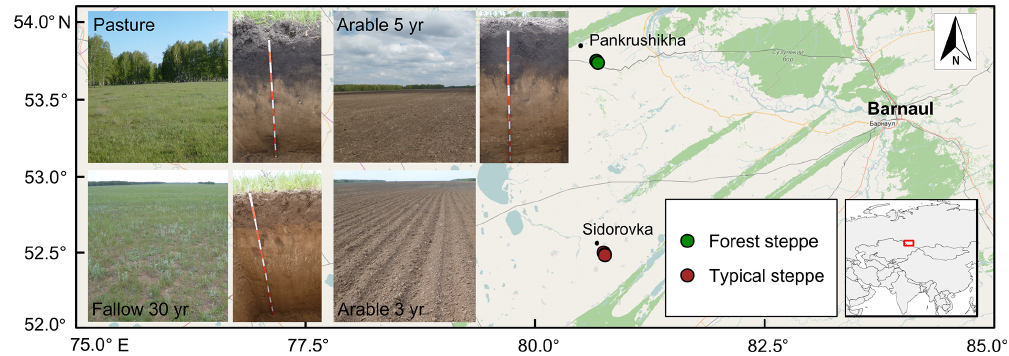
Figure 1. Map of the study area and pictures from the two sites near Pankrushikha and Sidorovka. Map modified from ©OpenStreetMap contributors, for copyright see